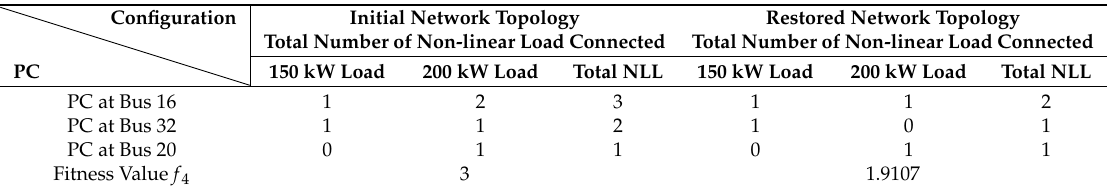
Table 3. The total number of Non-Linear Loads (NLL) connected to the radial path of the Priority Customer (PC) bus in the initial topology (without fault) and in the restored network topology.